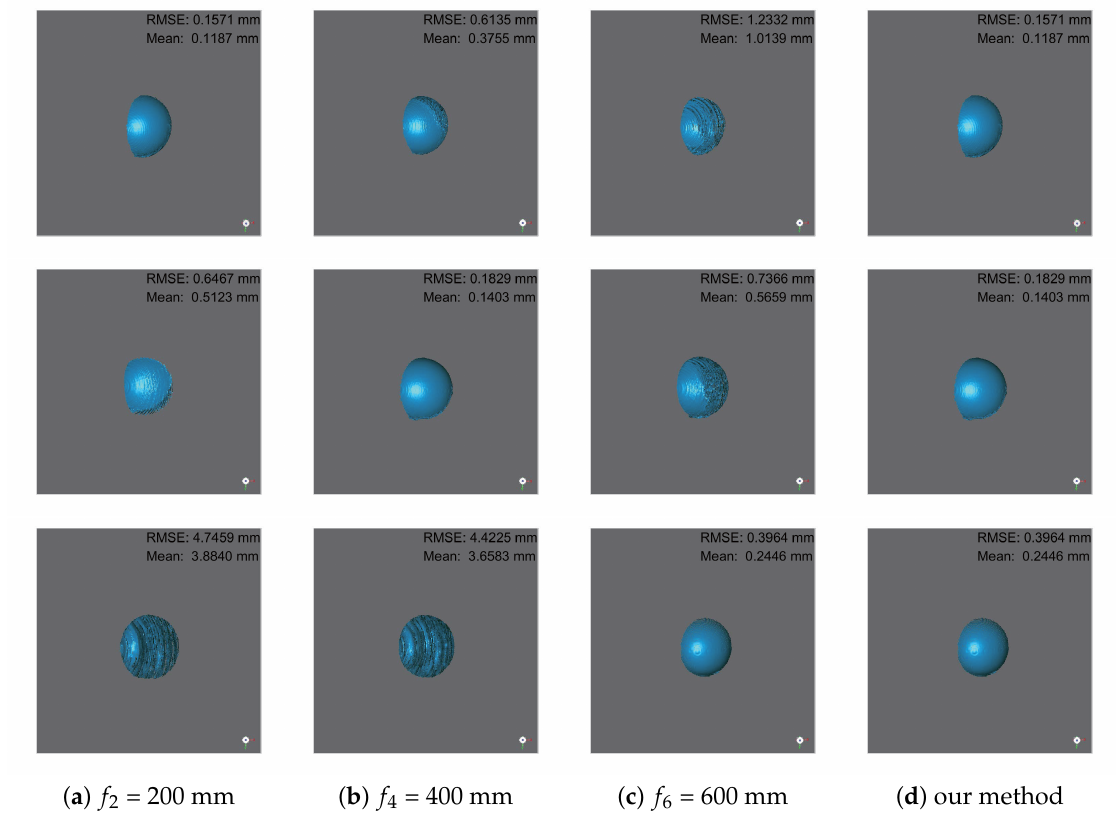
Figure 6. Comparison of reconstruction results. ( a ) f 2 = 200 mm; ( b ) f 4 = 400 mm; ( c ) f 6 = 600 mm; ( d ) our method. The first row represents the results of the small sphere (diameter = 30 mm at 200 mm) under different camera settings and methods. The second row represents the corresponding results of the medium sphere(diameter = 50 mm at 400 mm), and the last row represents the corresponding results of the big sphere(diameter = 70 mm at 600 mm). The reconstruction errors are shown in the upper right corner of each figure, which are RMSEs and mean